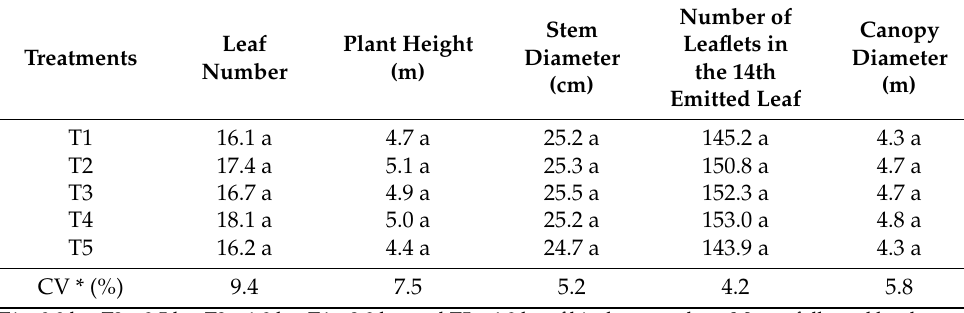
Table 4. Plant development biometric variables, 750 days after